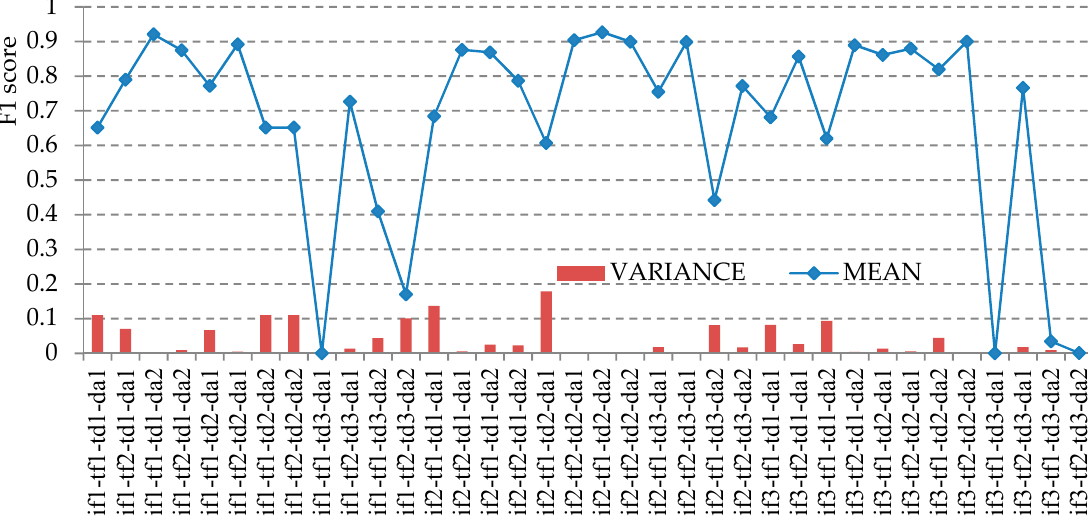
Figure 4. Illustration of the mean and variance of F1 scores on all 10 test data based on the 36 FCN models with different parameter settings, as indicated in Table 2.